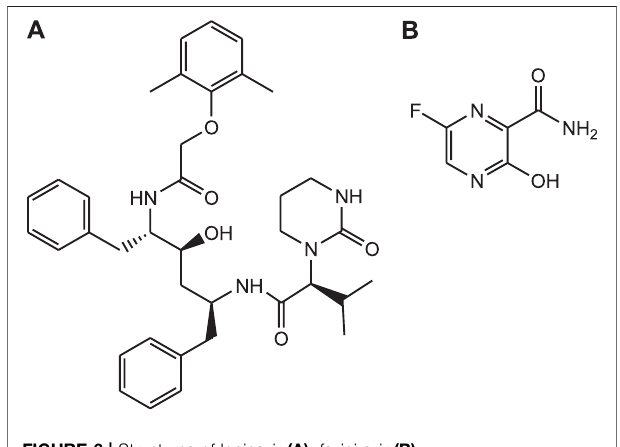
FIGURE 6 | Structures of lopinavir (A) , favipiravir (B)